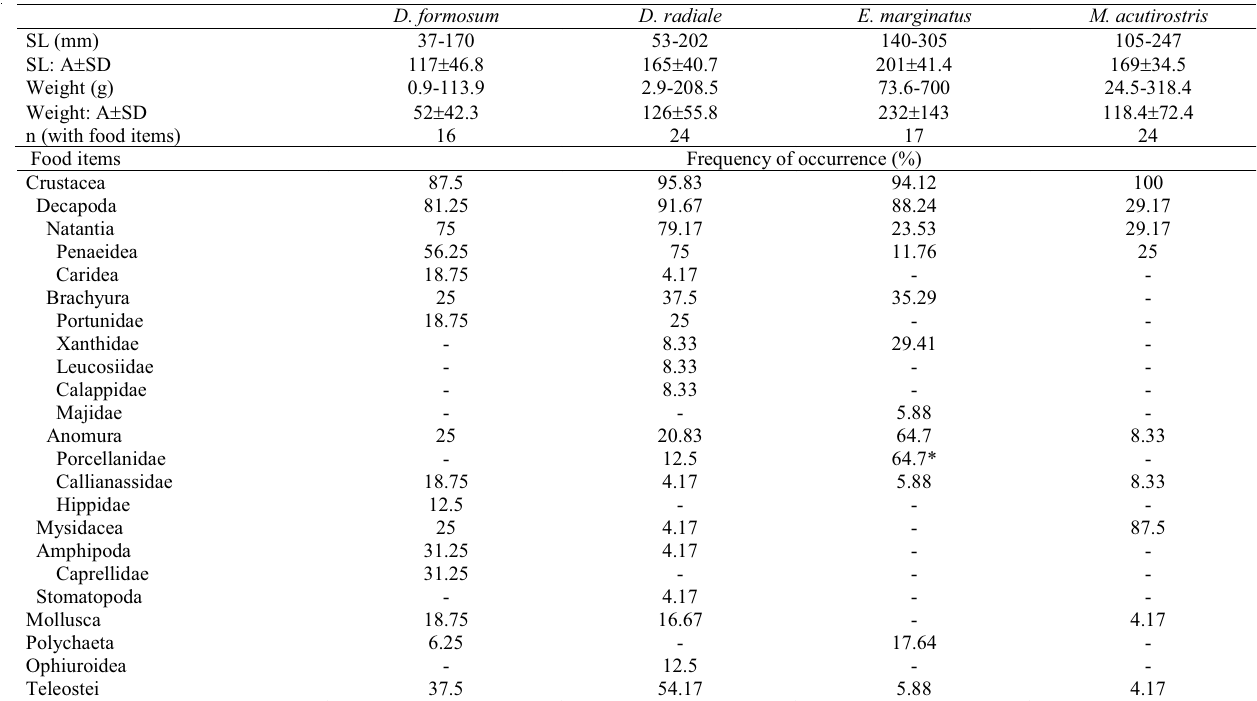
Table 3. Frequency of occurrence (%) of food items of Diplectrum formosum (n=20); D. radiale (n=30); Epinephelus marginatus (n=30); and Mycteroperca acutirostris (n=30). A = average; SD = standard deviation; “-” indicates the absence of the correspondent item. *All of the porcelain crabs found in the dusky groupers’ stomach were Petrolisthes galathinus . D. formosum